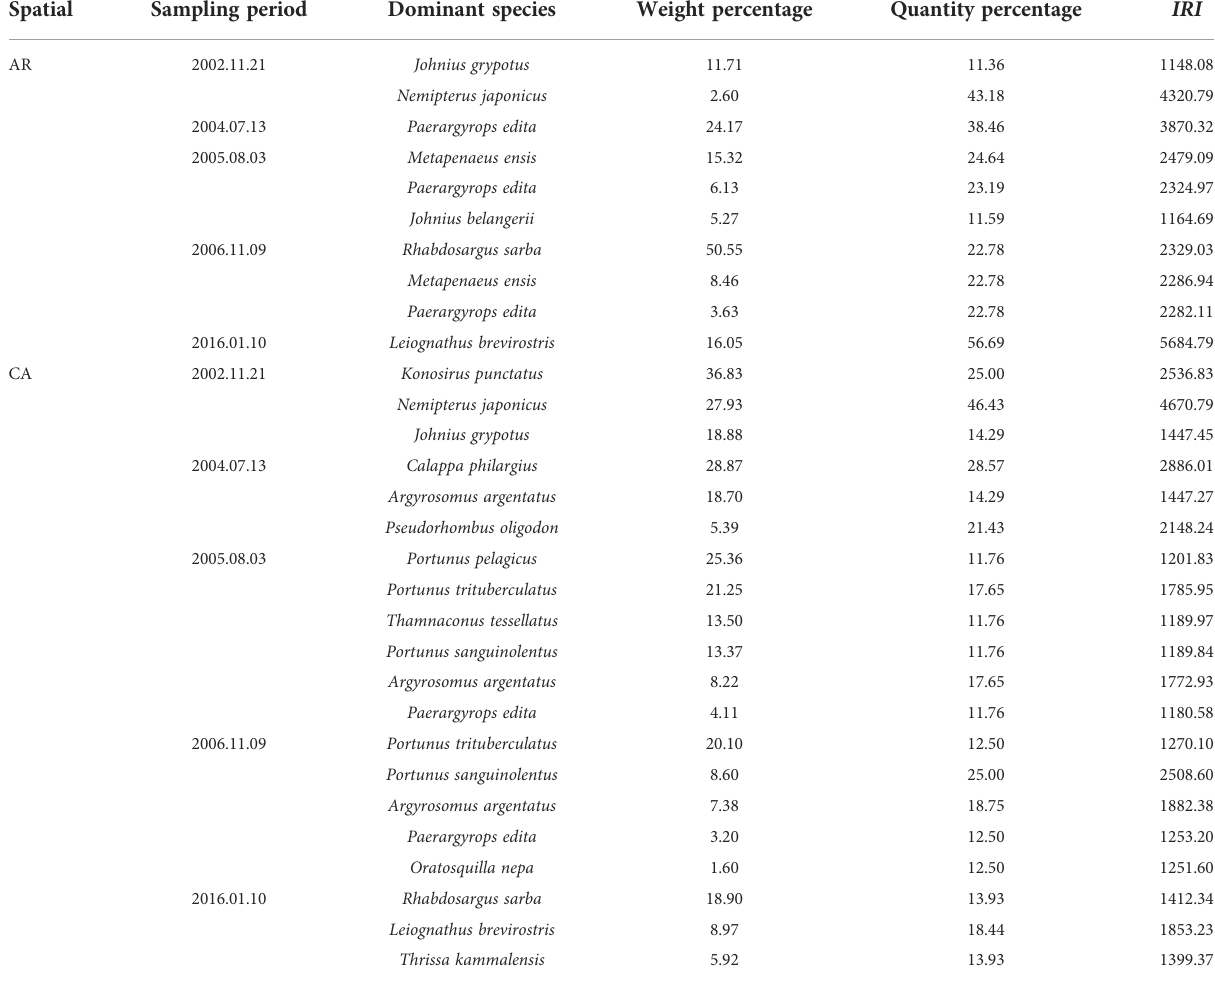
TABLE 5 Dominant species of nekton community in AR and CA habitat surveyed during gill net sampling period.